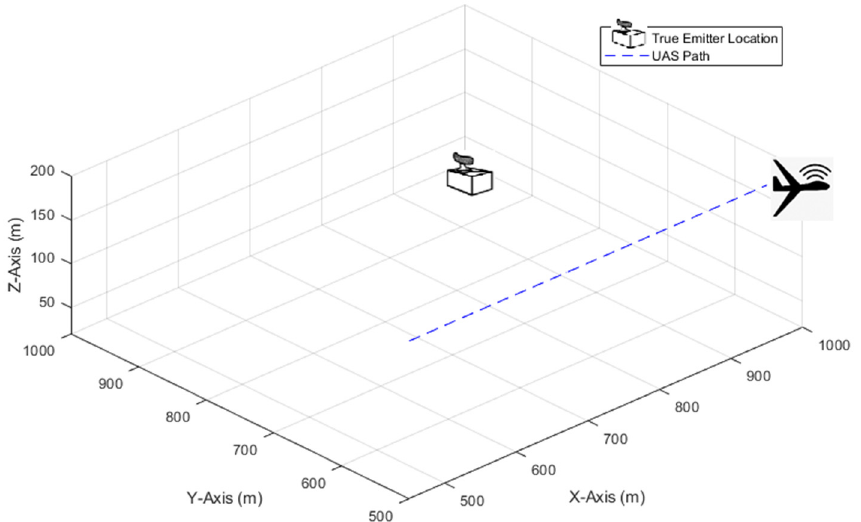
Figure 4. True emitter location and linear flight path of the UAS.